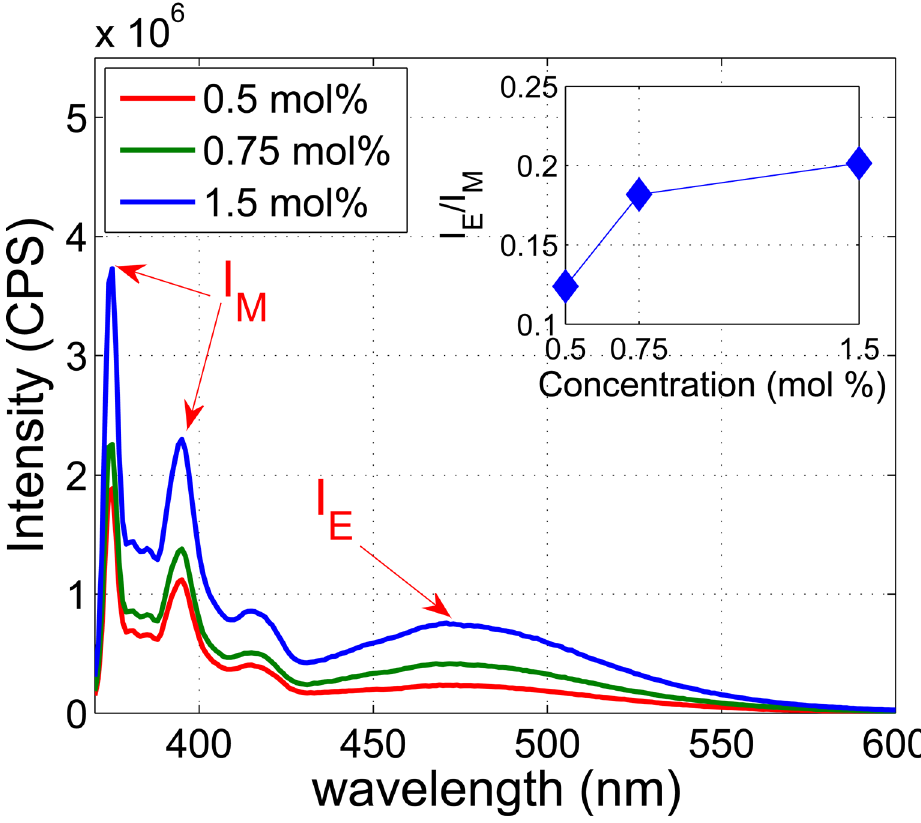
Fig 2. Emission spectra of liposomes containing 0.5 mol %, 0.75 mol %, and 1.5 mol % PyPC. The same total lipid (DPPC and PyPC) concentration (1.28 mM) was used in all cases. The intensity ratio of excimer (I E ) and monomer (I M ) for each concentration is shown inset in which data is fitted using linear interpolation. CPS: counts per